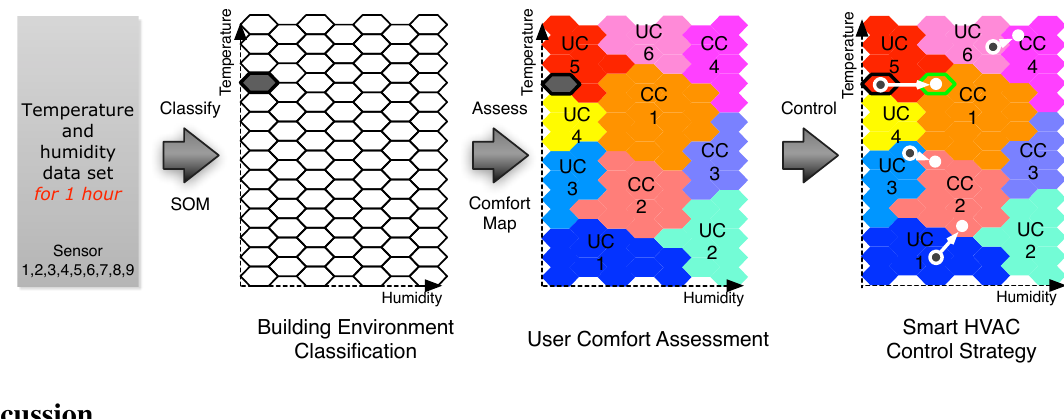
Figure 7. Overall procedure of the HVAC control strategy for providing occupants with a comfortable working (or home)